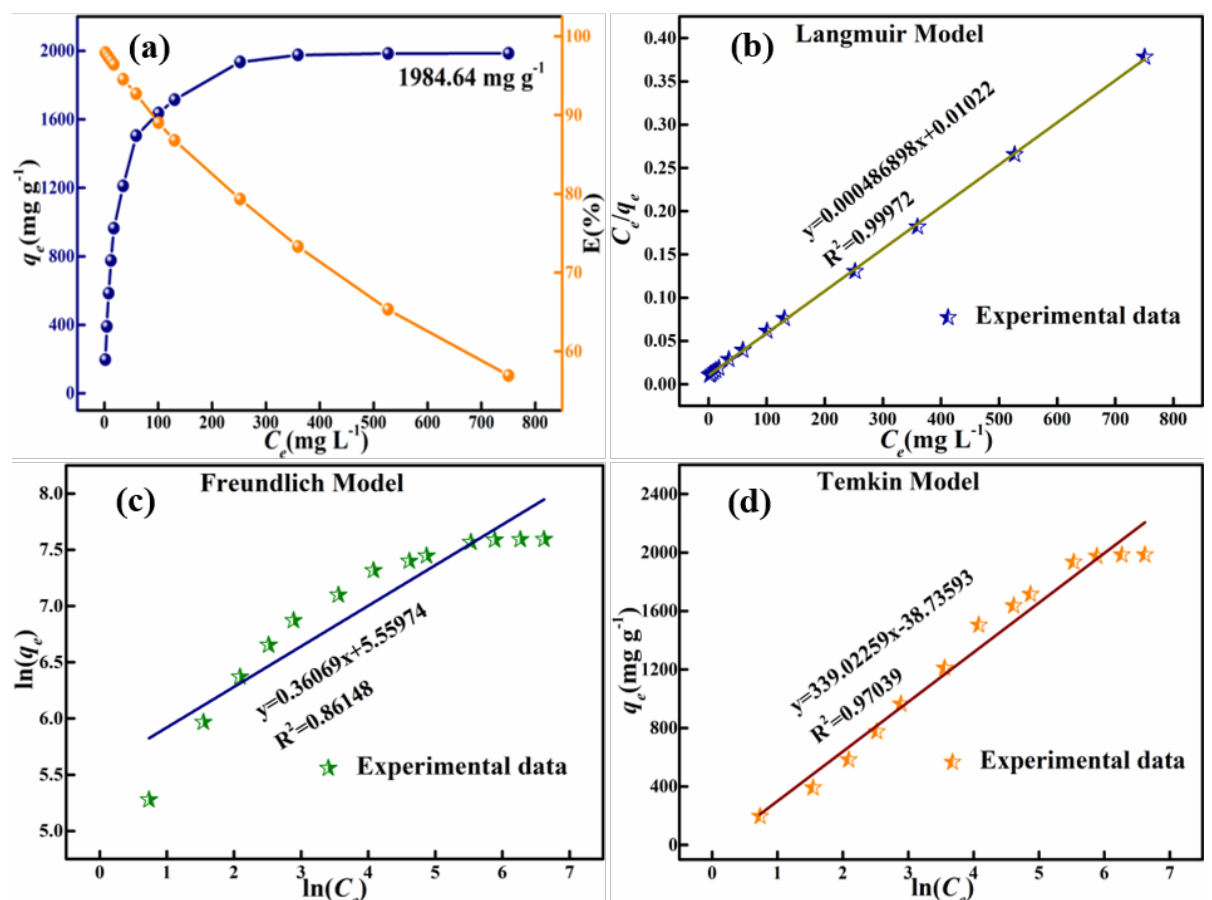
Figure 10. ( a ) Adsorption isotherms and percentage removal of CR as a function of the initial concentration; plots fitted with ( b ) Langmuir Model, ( c ) Freundlich Model and ( d ) Temkin Model for adsorption of CR on samples HPMA (T = 25 ◦ C, adsorbent mass = 100 mg and pH = Table 12. Adsorption isotherms parameters for adsorption of CR on the HPMA powder.